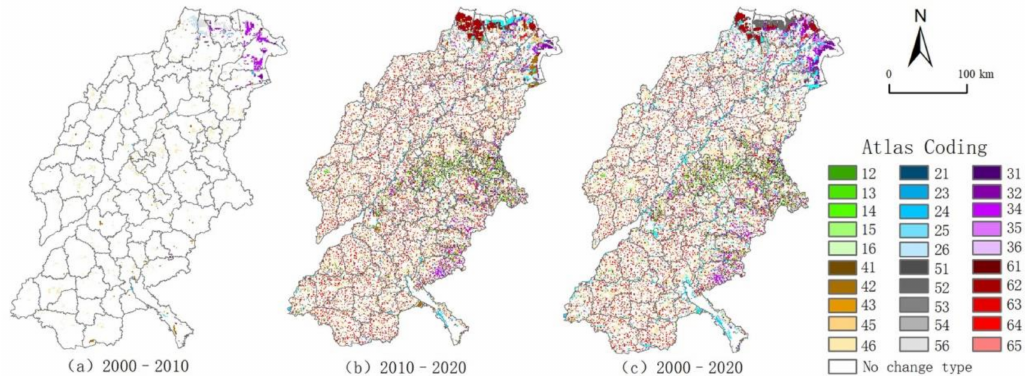
Figure 4. Map of land use changes in typical areas of the Yellow River Basin from: ( a ) 2000–2010, ( b ) 2010–2020, and ( c )